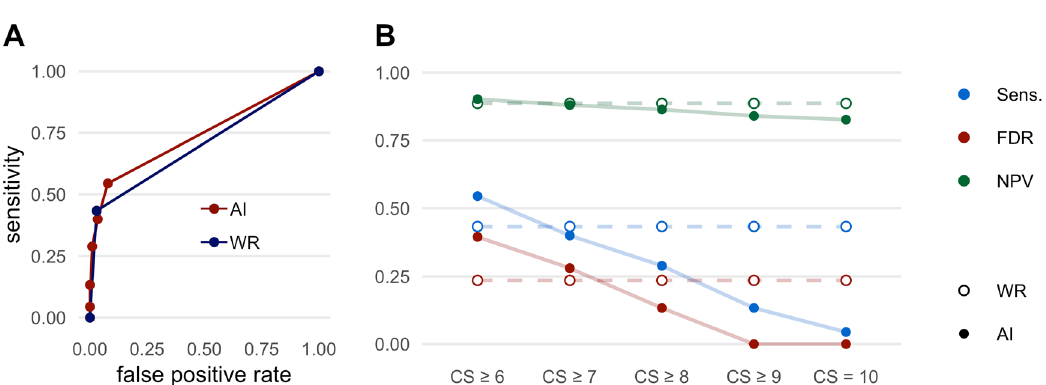
Figure 5. Performance metrics for the detection of atelectasis. ( A ) Receiver operating characteristic (ROC) curves displaying the performance of the AI Rad Companion Chest X-ray (AI) and the radiologists (WR = written report) for the detection of atelectasis (area under the curve (AUC) AI = 0.743/WR = 0.702). ( B ) Sensitivity (Sens.), negative predictive value (NPV) and false discovery rate (FDR) of the AI Rad Companion Chest X-ray (AI) and the radiologists (WR = written report) for the detection of atelectasis. The sensitivity of the AI is slightly higher at a (confidence score =) CS ≥ 6; at the same time, the FDR is slightly higher. At CS ≥ 7, sensitivity and FDR of the AI and the WR are on a similar level. At CS ≥ 8, the sensitivity as well as the FDR decrease markedly. The NPV of the AI is high at all CS.